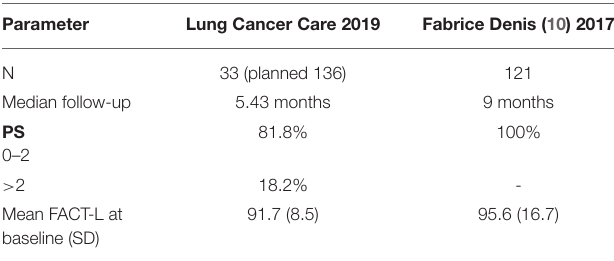
TABLE 5 | Demonstrated differences in patient characteristics between our study and related study (10).